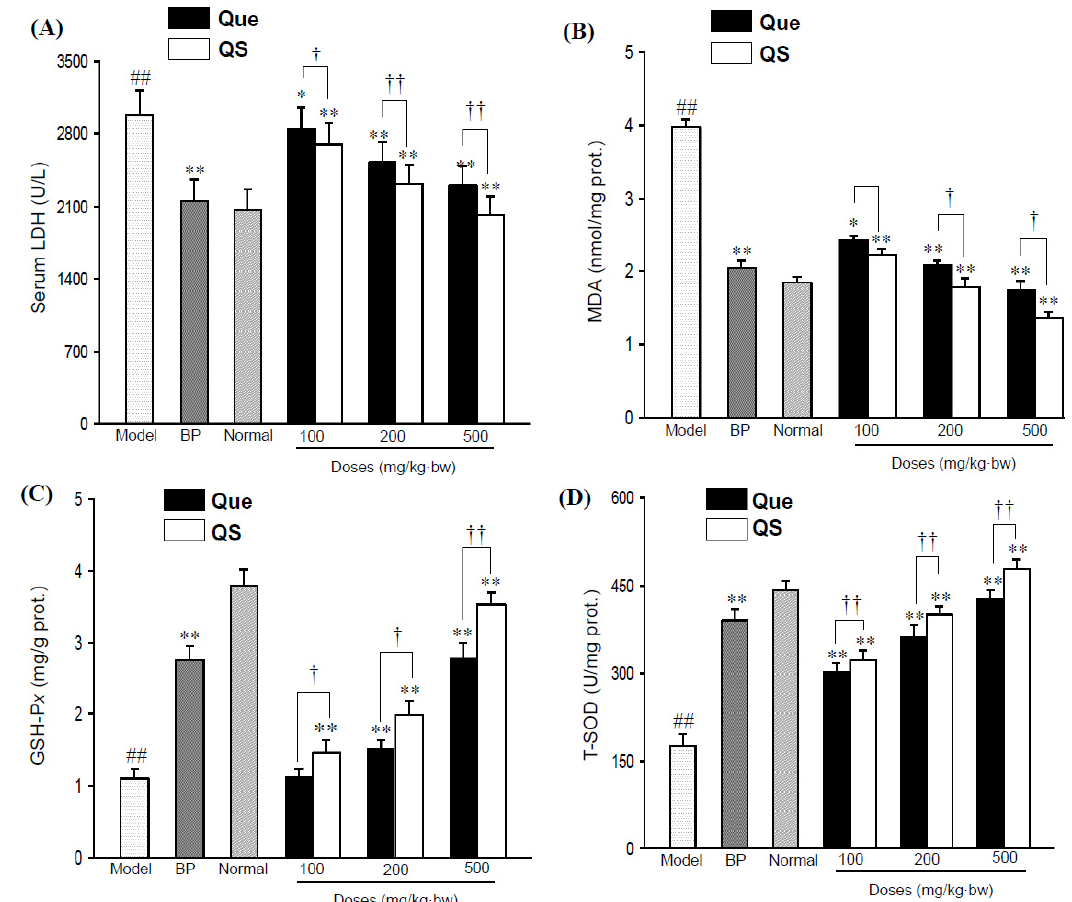
-intoxicated mice 4 4 -intoxicated group. † p < 0.05 4